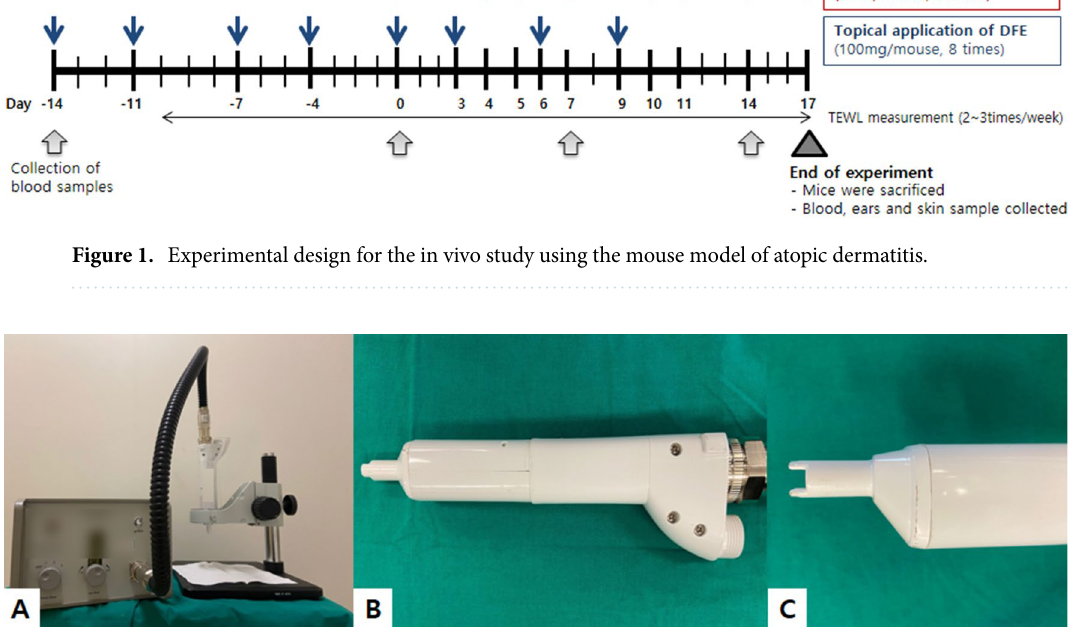
Figure 2. Photographs of the investigated cold atmospheric plasma device. ( A ) During the treatment, the handpiece was held static using a clamp. ( B ) The handpiece is designed similar to other conventional energy- based devices and can be easily held manually. ( C ) The tip of the handpiece is equipped with a 5 mm-long plastic cover, which keeps the distance from the plasma jet and the treated area